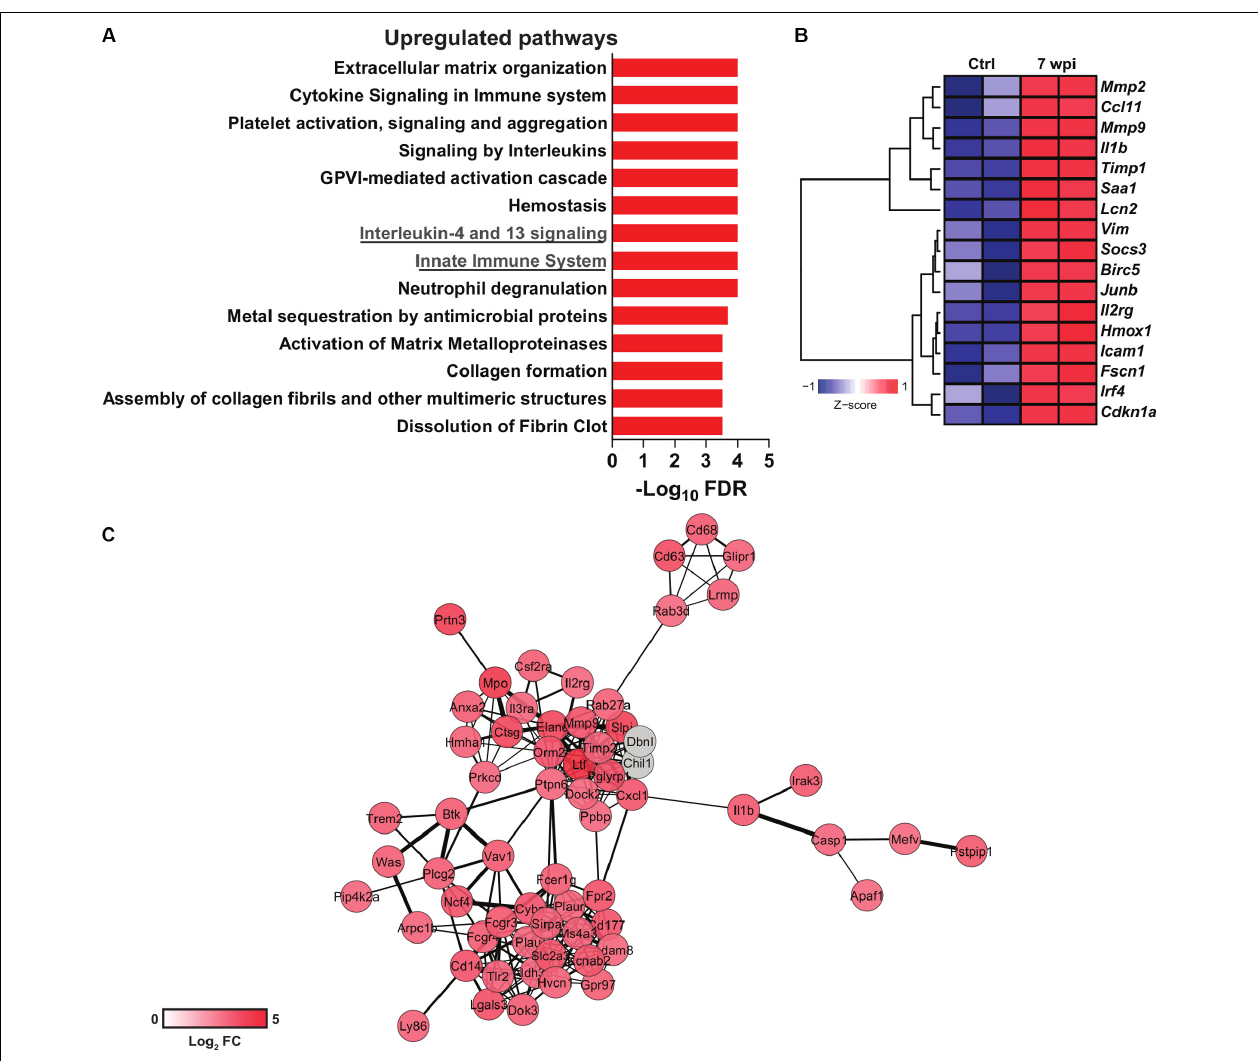
FIGURE 1 | Transcriptomics data reuse of mice infected with S. japonicum . Normalized gene expression data from livers of mice infected with S. japonicum for 7 weeks and naïve mice were acquired at the Gene Expression Omnibus (GEO) repository (GSE14367). Differential gene expression was evaluated with the package limma for R. (A) Pathway enrichment analysis of upregulated genes in liver of S. japonicum- infected mice. Pathways were evaluated with the ToppGene suite platform (Chen et al., 2009) and the bar plot depicts the significance of enrichment in each pathway as shown by -log 10 p -values adjusted by Benjamini-Hochberg false discovery rate (FDR) method. (B) Heat map showing the expression of genes included in the interleukin-4 and 13 signaling pathway in S. japonicum -infected and naïve mice. Hierarchical clustering was performed with the package amap for R using Euclidian distance metric and Ward linkage. The heat map was generated with the package gplots for R. (C) Gene network composed of genes included in the innate immune system pathway. The network was generated with the platform STRING v11.0 (Szklarczyk et al., 2015) and visualized with Cytoscape v3.7.2 (Shannon et al., 2003). The color scale is proportional to the log 2 fold changes of each gene from S. japonicum -infected mice over naïve mice. Genes colored in gray were imputed by STRING but were not present in the evaluated